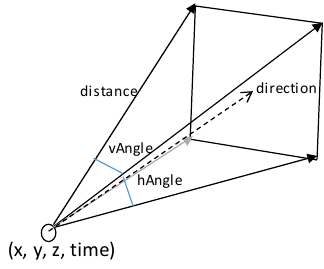
Figure 3. A Field of View in a geo-tagged photo  STPhoto : STPhoto is a type for a geo-tagged photo with a FoV. A STPhoto data is a tuple of ( imguri, loc, t, fov). imguri is a universal locator of the image file, loc is a tuple of ( x, y, h ), and t is a timestamp of image which was taken. Also, fov is a tuple of (hAngle, vAngle, direction, distance) as shown in Figure 3. hAngle is the maximum horizontal angle of the camera lens, vAngle is the maximum vertical angle of the camera lens, distance is the maximum visible distance from the camera, direction is the angle from the